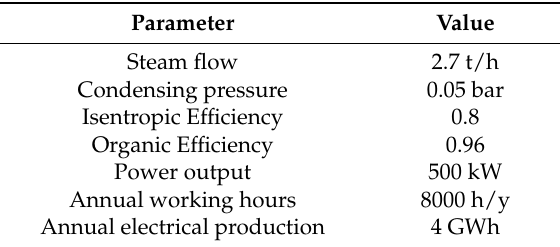
Table 4. Steam cycle